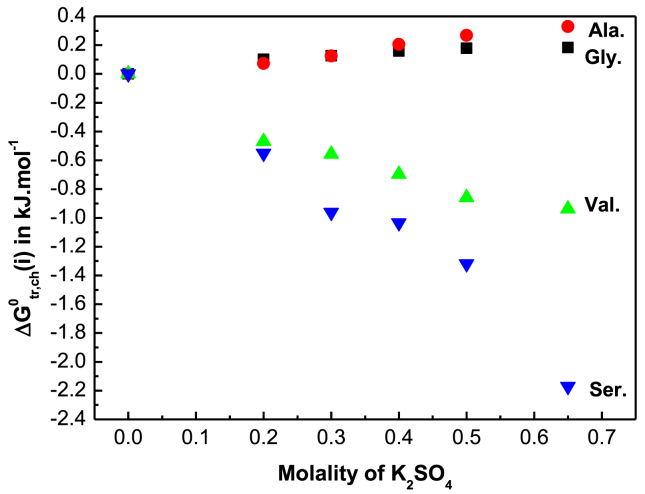
Variation of ΔGtr,ch0(i)in kJ·mol−1with molality concentration of K2SO4 in aqueous K2SO4 solution for glycine (■), D,L-alanine (●),D,L-serine (▼) and D,L-nor-valine (▲) at 298.15 K.